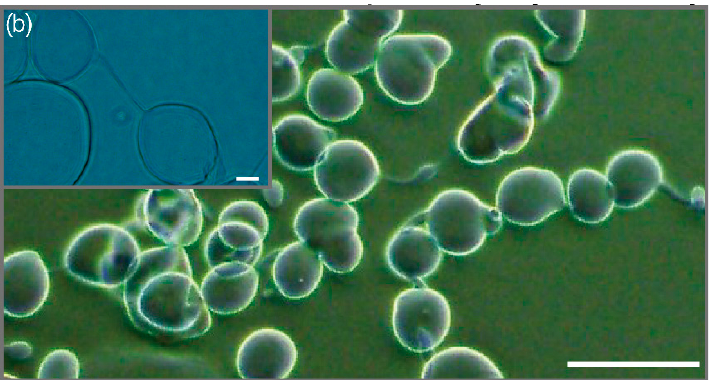
Figure 5. Beads-on-a-string structure made of calcium alginate: ( a ) Schematic diagram of the formation process of the beads-on-a-string structure. Viscous capillary jet of Na-alginate solution under deformation due to hydrodynamic instability directly gelated in the CaCl 2 solution before complete break-up; ( b ) Fabricated beads-on-a-string structures. The inset shows the string connecting the microbeads as small as sub-micron scale in thickness. The scale bars are 10 μm in the inset and 100 μm in the main frame.